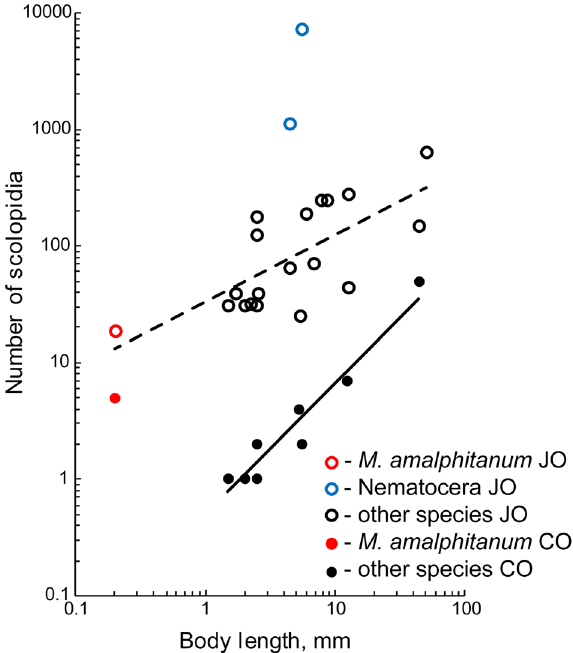
Figure 6. Changes in number of JO and CO scolopidia with body size in insects. For this chart the OLS method was used; the dashed line designates JO OLS, the solid line designates CO OLS. Data source see Table